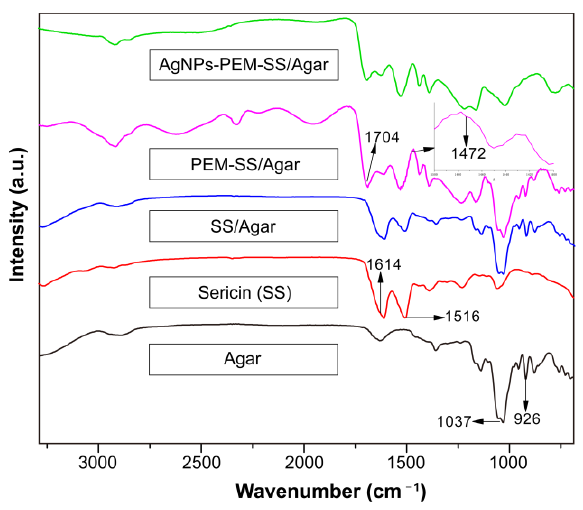
Figure 3. FT‐IR spectra of agar, sericin, SS/Agar film, PEM‐SS/Agar, and AgNPs‐PEM‐SS/Agar films.